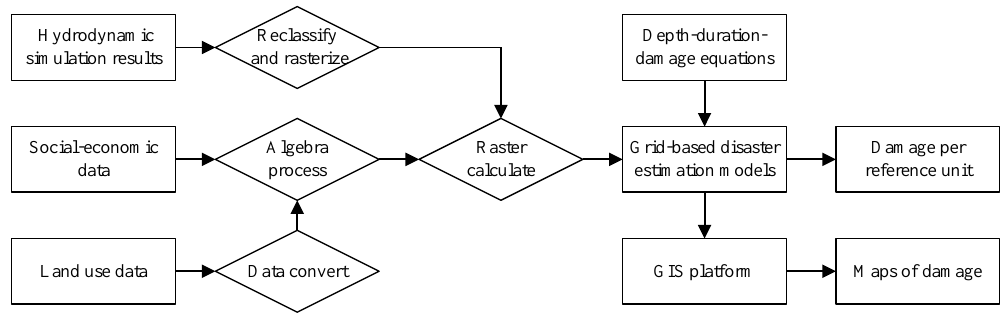
Fig. 13. The process of the flood submerging analyst and flood hazard loss evaluation.